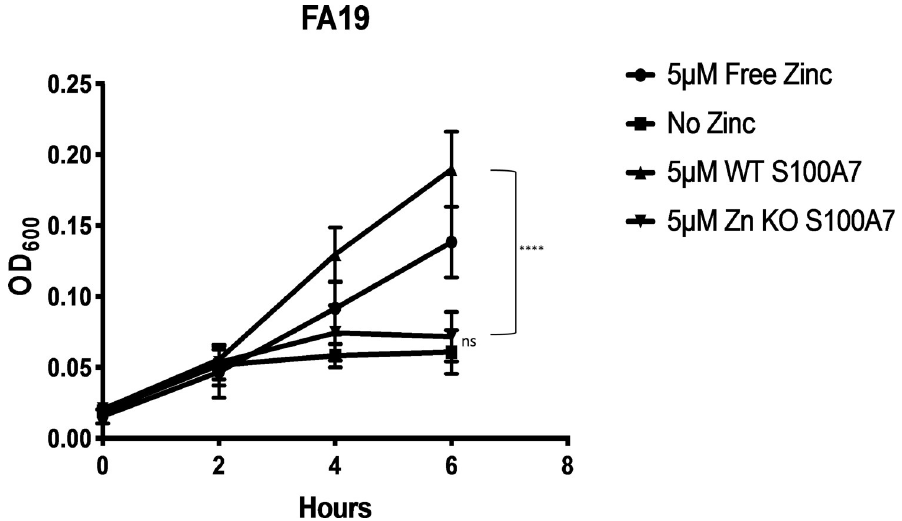
Fig 11. Mutated S100A7 unable to bind zinc is deficient in TdfJ-dependent growth support. Both wildtype S100A7 and the S100A7 mutant incapable of binding zinc were mixed with ZnSO 4 at a 2:1 molar ratio and incubated with end- over-end mixing for 18 h to allow any zinc loading to occur. After this, both mixtures were dialyzed against Chelex- 100-treated dialysis buffer to remove any unbound ions before being utilized in growth premix. Strain FA19 was grown in Zn-restricted CDM supplemented with premix containing either wildtype or mutant S100A7, with OD 600 readings taken every 2 h for 6 h total. The graph demonstrates means and SD for N = 3 independent experiments. A 2-way repeated measures ANOVA with Tukey’s correction was performed for all means, with significance at 6h shown. � , P � . 05; �� , P � .005; ��� , P � .0005; ���� , P � .0001.